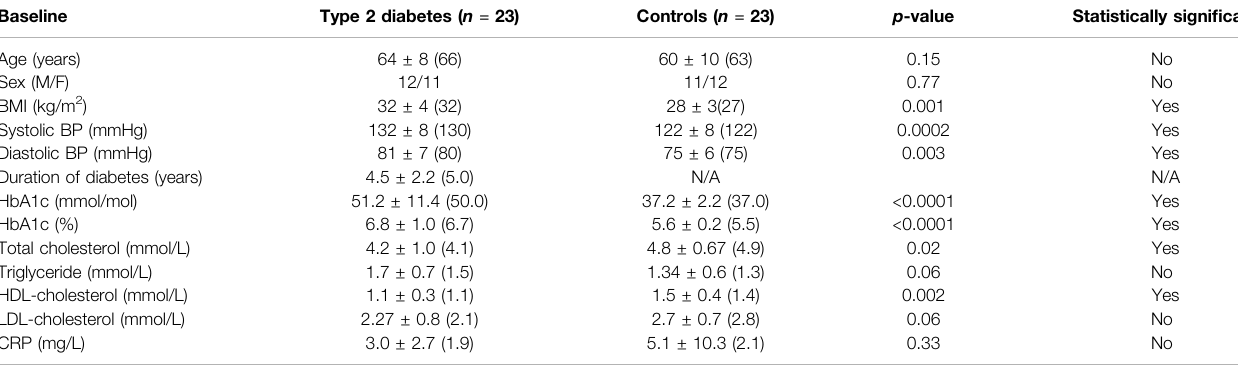
TABLE 1 | Study participant demographic and biochemical data. Data is presented as Mean ± 1 SD (Median). Baseline